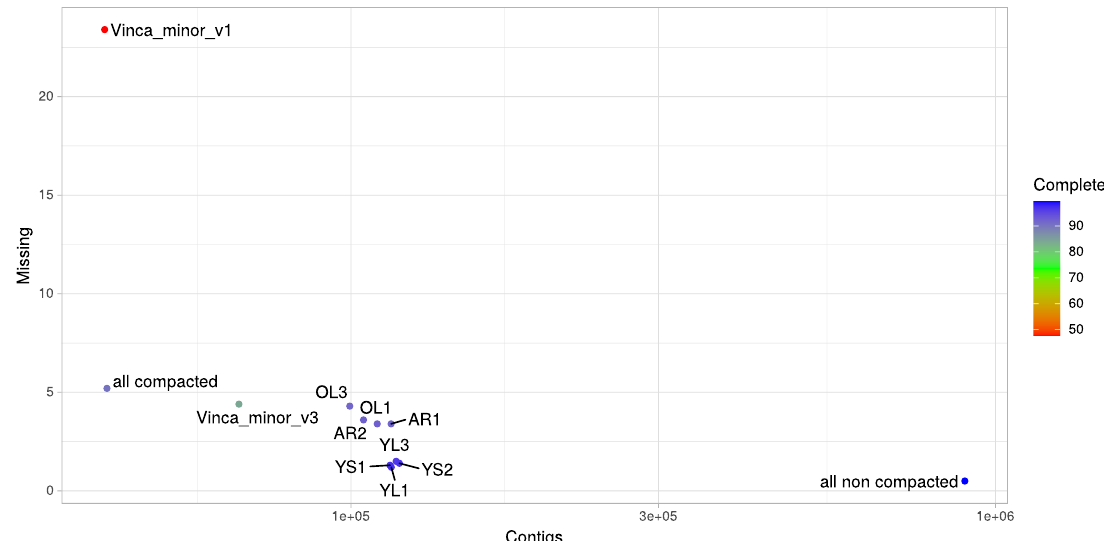
Figure 3. BUSCO evaluation of transcriptome assembly quality. The number of missing BUSCOs is plotted against the total number of contigs. Colors correspond to the percentages of completed BUSCOs. BUSCO analysis was conducted for each individual sample transcriptome for old leaves light (OL), young leaves light (YL), young leaves shadow (YS) and adventitious roots (AR), and their merged transcriptome without (all non compacted) and with compaction (all compacted). BUSCO metrics were compared with available V. minor transcriptome resources including the 454 based assembly (Vinca_minor_v1) and the Illumina based assembly